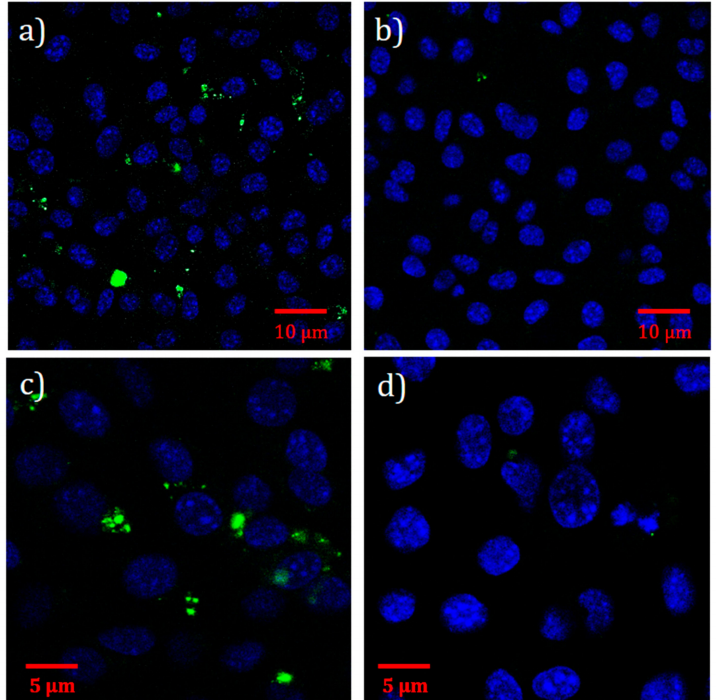
Figure 9. Immunofluorescence of graphene oxide platforms with magnetic nanoparticles modified antibodies (GO-MNps-MAb) into the B16 cells. Sample GO-MNps-MAb was examined in ( a ) B16 cells with carbonic anhydrase IX (CA IX) and ( b ) B16-neo cells without CA IX. Sample with the binding agent graphene oxide platforms with magnetic nanoparticles modified antibodies in the presence of 1–ethyl–3–(3–dimethylaminopropyl) carbodiimide (GO-MNps-EDC-MAb) were examined in the same cell types: ( c ) B16 CA IX and ( d ) B16-neo